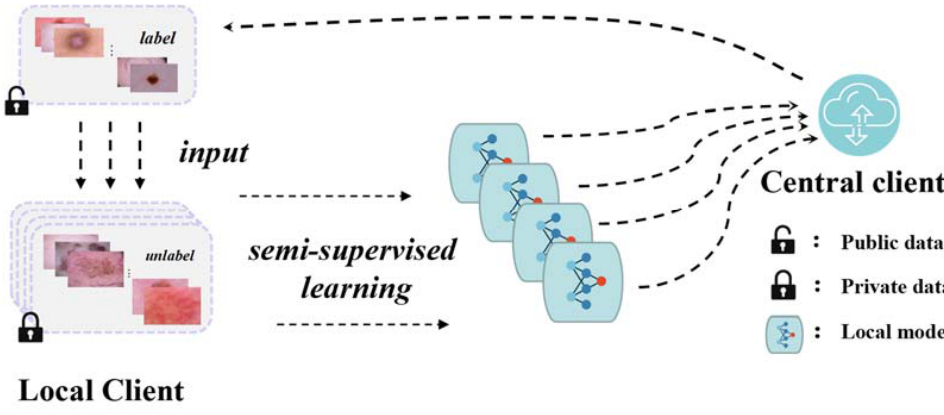
Figure 2. Framework of our proposed federated learning